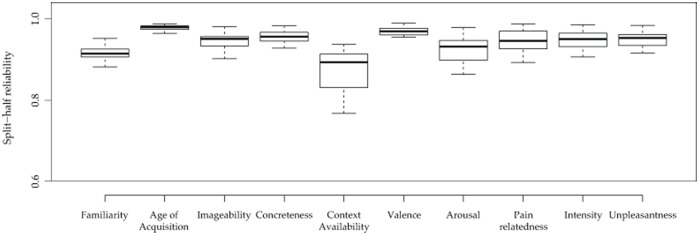
Measures reliability.Distribution Boxplots of the overall half-split reliability distributions over 1,000 random replicates, run separately for each questionnaire and for each variable.